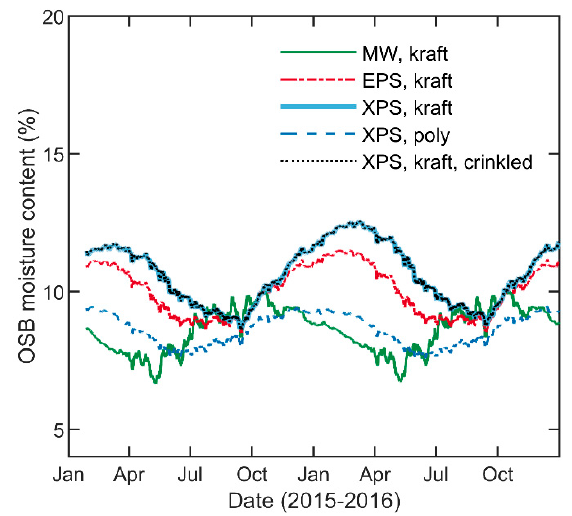
Figure 4. Simulated moisture content of OSB in north facing design walls with exterior insulation.